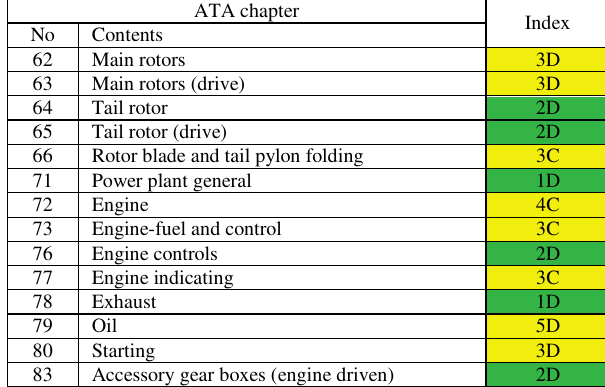
Table 13. Safety risk assessment matrix for turboshaft engine systems